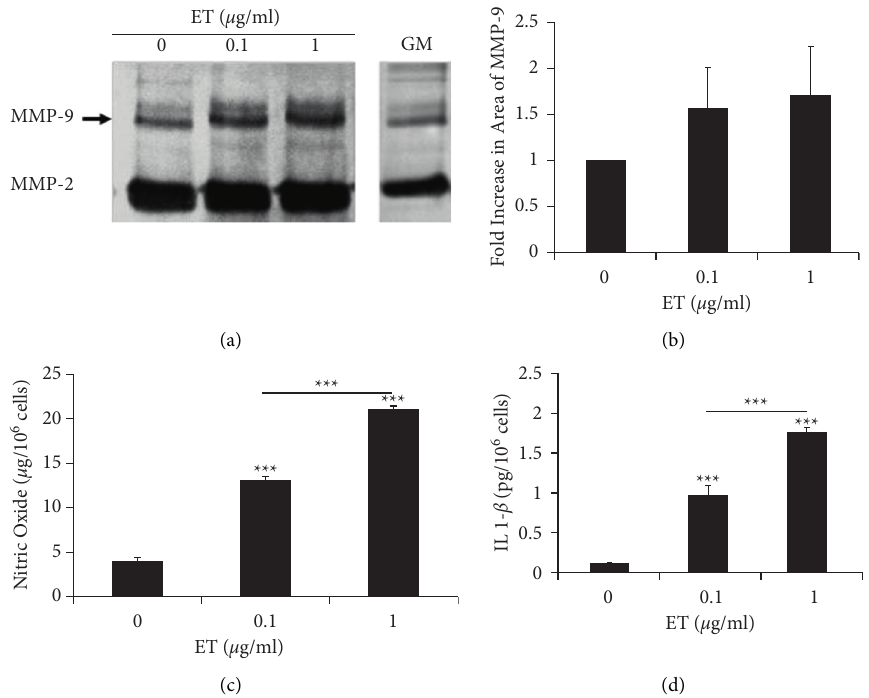
Figure 2: Short-term endotoxin treatment upregulates levels of inflammatory mediators produced by MDA-MB-231 human breast cancer cells. (a) Gelatin zymography of conditioned media collected from untreated control (0 µ g/ml) and ET-treated cells (0.1 and 1 µ g/ml) upon reaching 75% confluence after treatment showed upregulation of MMP-9 activity in MDA-MB-231 cells. No differences in the growth profile of ET-treated cells were noted, and all cultures reached 75–80% confluence within the same time frame. (b) Quantification of fold increase in peak area of MMP-9 bands shown in the previous zymogram. Each bar represents triplicate analyses of mean ± SD. The abundant unregulated MMP-2 levels noted in the conditioned media are also noted in growth medium (GM). (c) Upregulation of NO and (d) IL 1- β levels in MDA-MB-231 conditioned media collected from ET-treated cells (0.1 and 1 µ g/ml) compared to untreated controls (0 µ g/ml), upon reaching 75% confluence after treatment. Each bar represents triplicate analyses of mean ± SD. ∗∗∗ P < 0 . 001 compared to the untreated